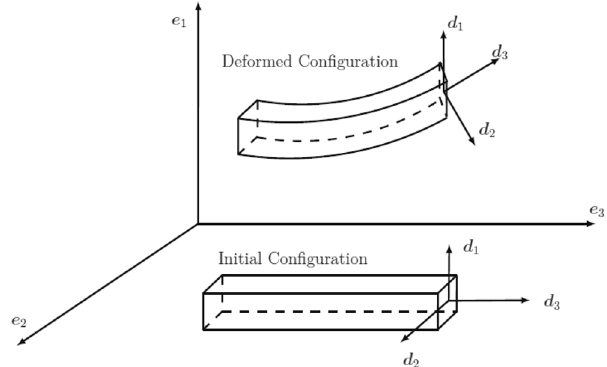
Figure 1. Basic kinematics of the